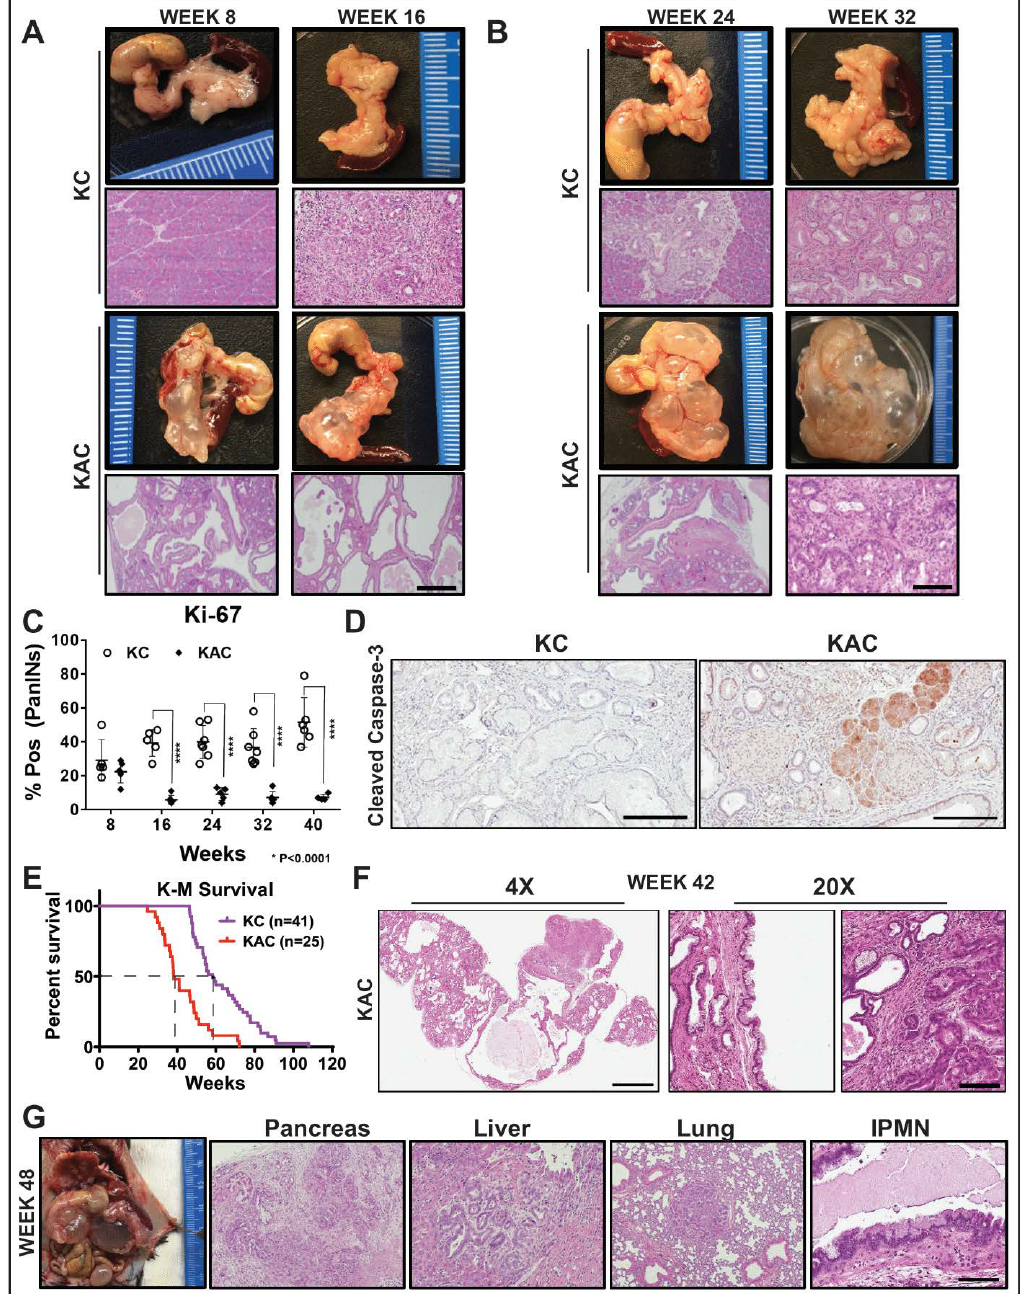
Figure 1. Conditional loss of Arid1a in mouse pancreas restricts growth of Kras-driven early premalignant lesions. ( A , B ) Representative gross macroscopic images and H&E stained